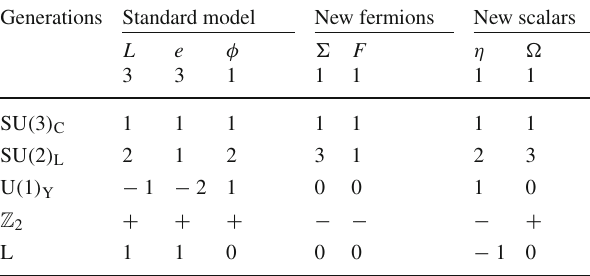
Table 1 Particle content and quantum numbers of the Singlet + Triplet ScotogenicModel.Thechargeassignmentsofthefieldsundertheglobal Lepton Number symmetry (L) are also